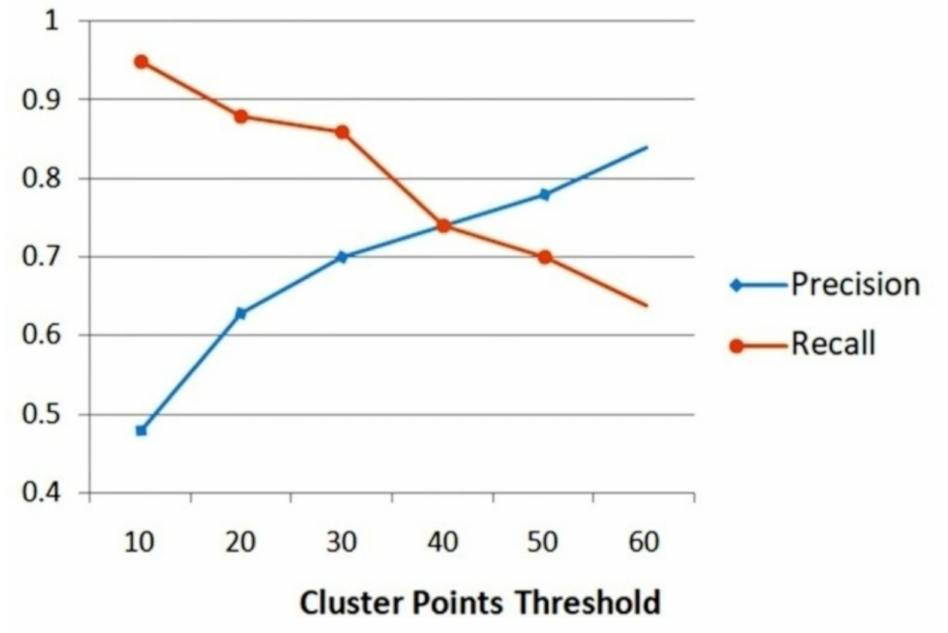
Figure 6. Detection precision and recall using di ff erent cluster-points